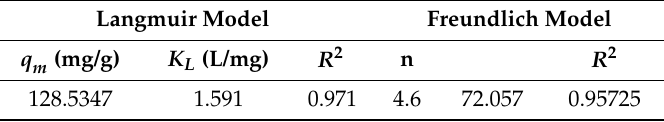
Table 2. Fitting parameters of adsorption isotherm models.